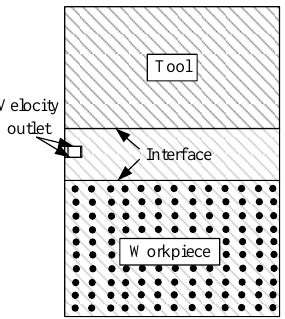
Figure 5. The boundary conditions in the throwing simulation model.